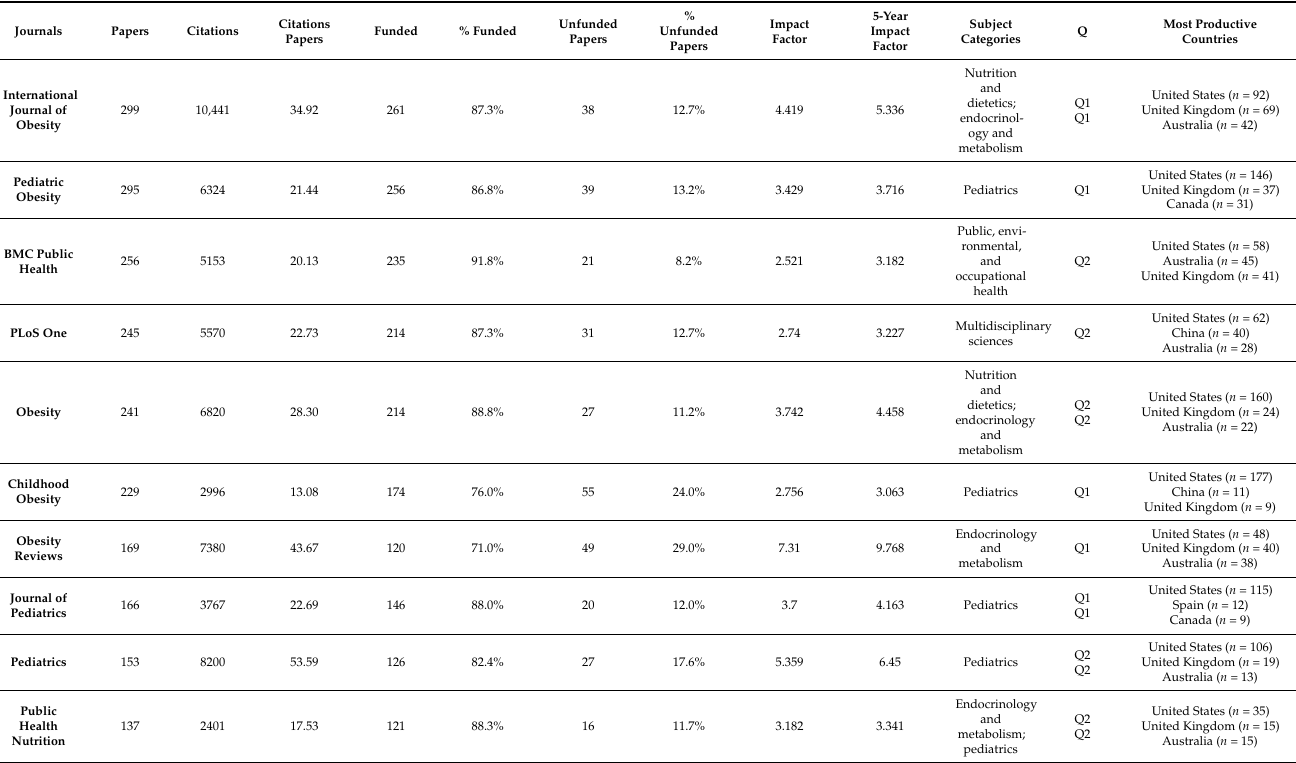
Table 2. Most productive journals, citations, citations per paper, impact factor, subject categories of journals, and most productive